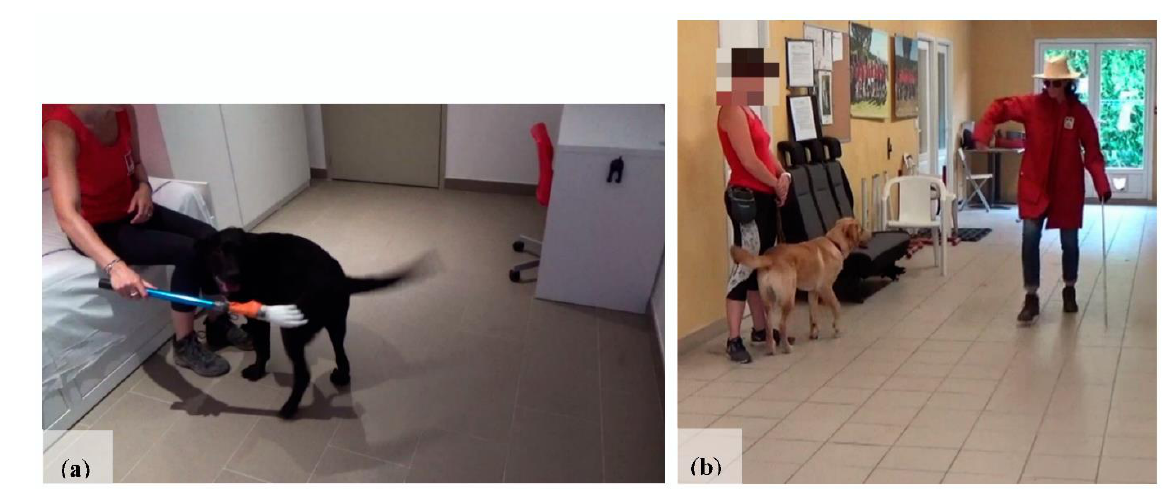
Figure 1. Photos of the rooms used for items 1 to 4 ( a ) and 5 ( b